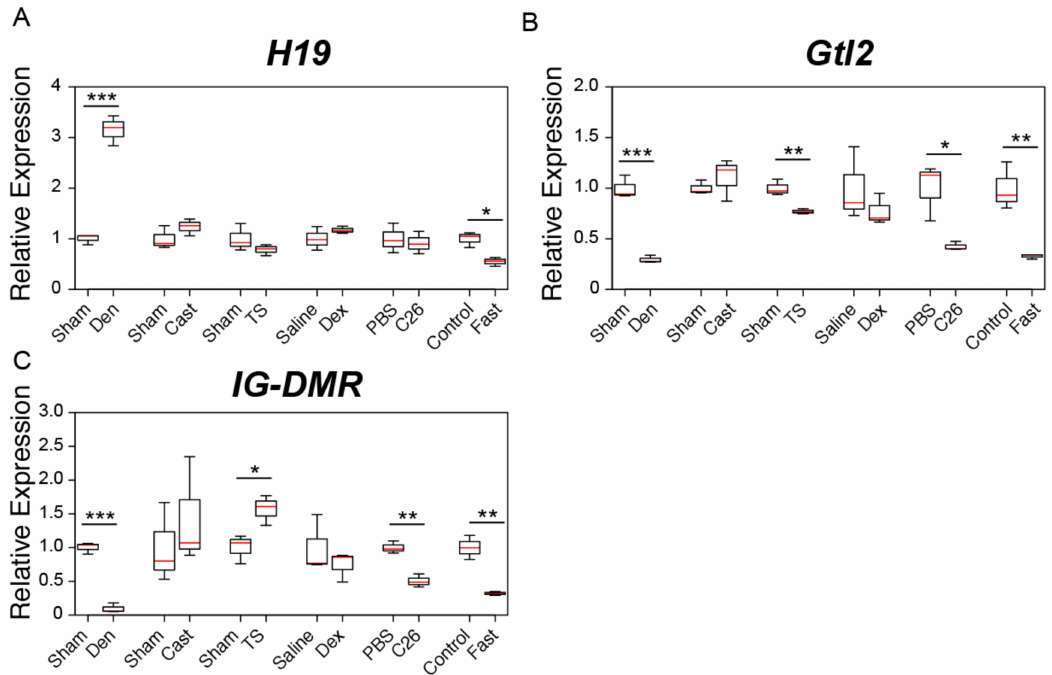
Figure 2. Changes in the expression of genomic imprinting-related lncRNAs in six muscle atrophy conditions. ( A – C ) Box-and-whisker plots showing the results of quantitative RT-PCR (qRT-PCR) for H19 ( A ), Gtl2 ( B ) and IG-DMR ( C ) expression in multiple muscle atrophy models. Sham; tibialis anterior (TA) muscles of sham-operated C57BL / 6J mice. Den; denervated TA muscles of C57BL / 6J mice. Cast; casting-operated TA muscles of C57BL / 6J mice. TS; TA muscles of tail suspension-operated C57BL / 6J mice. Saline; TA muscles of saline-injected C57BL / 6J mice. Dex; TA muscles of dexamethasone-injected C57BL / 6J mice. PBS; TA muscles of control phosphate-bu ff ered saline (PBS)-injected CD2F1 mice. C26; TA muscles of C26 tumor-bearing CD2F1 mice. Control; TA muscles of C57BL / 6J mice provided with water and food ad libitum. Fast; TA muscles of fasting C57BL / 6J mice. qRT-PCR data were normalized to Rpl26 expression and shown as relative expression. n = 3 per group. * p < 0.05. ** p < 0.01. *** p <